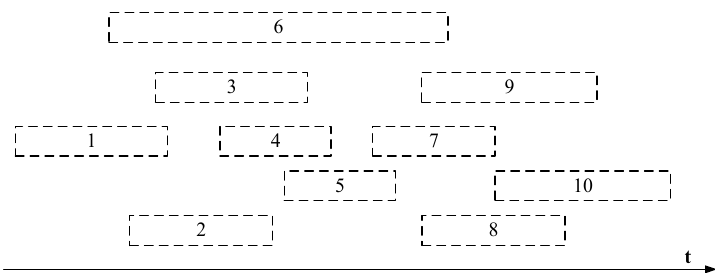
Figure 6. A diagram of 10 time windows.